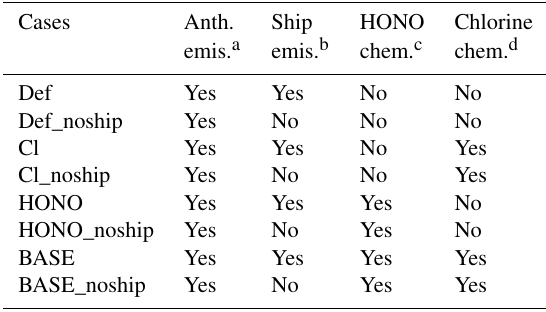
Table 1. Experimental